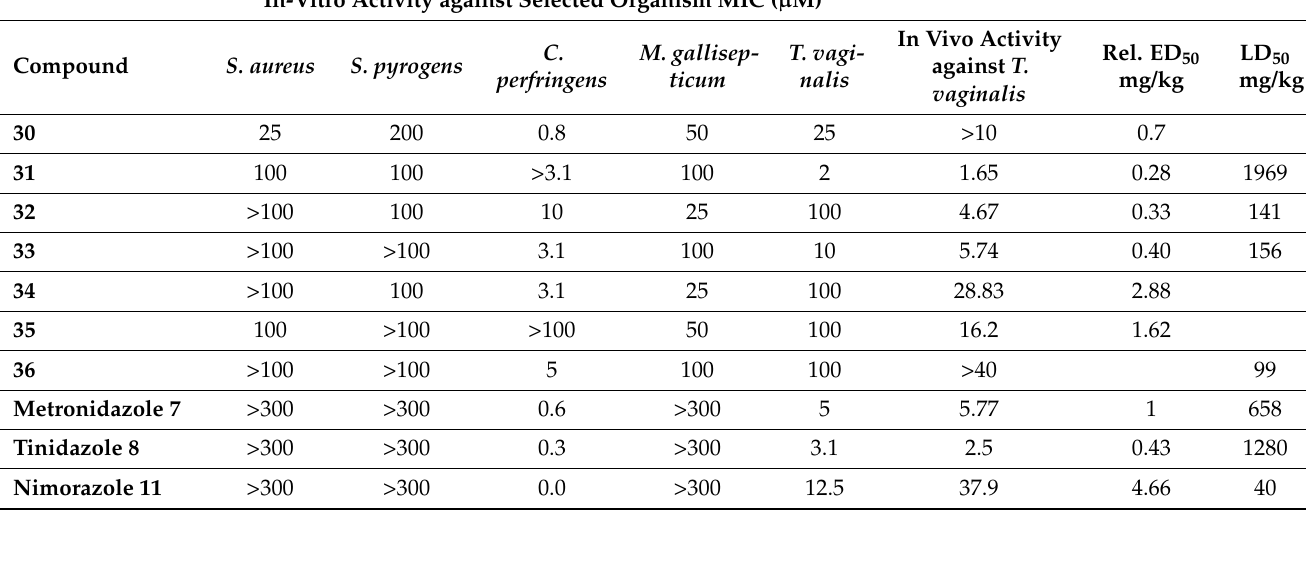
Table 2. In vitro and in vivo antibacterial activities.